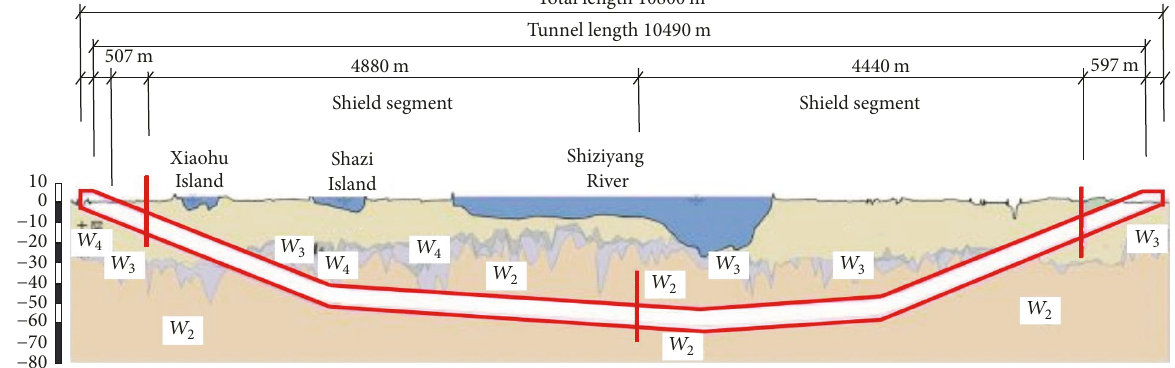
Figure 4: The vertical profile of the Shiziyang subsea tunnel.